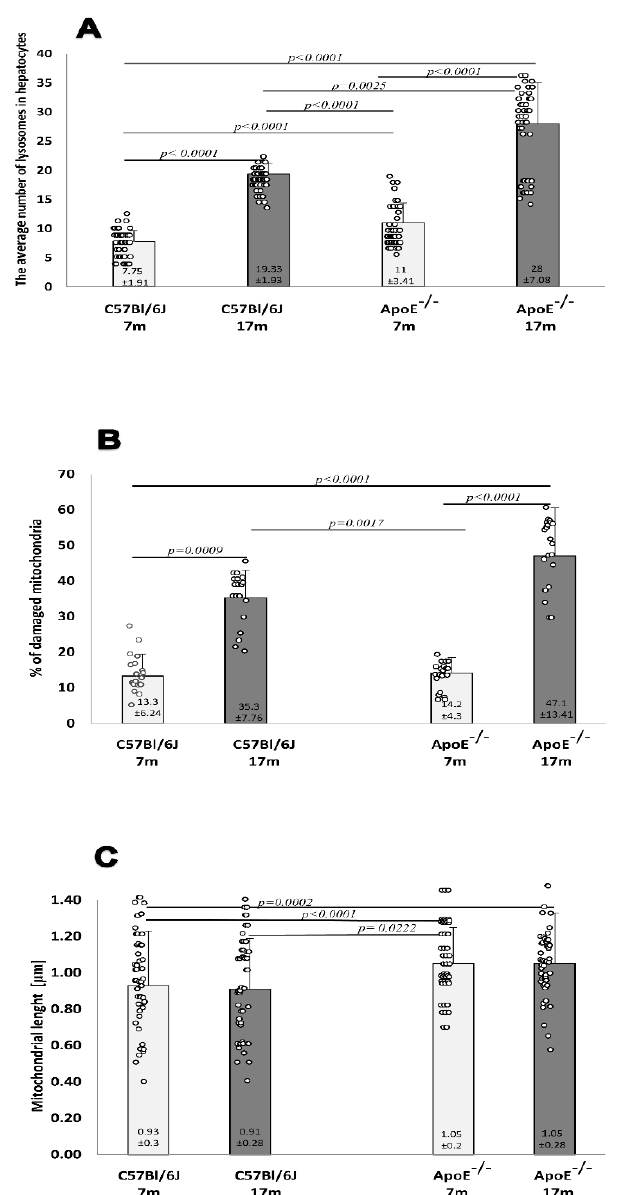
Figure 4. Senescence induces an increase in the number of damaged mitochondria and lysosomes in the mouse liver. Quantitative analysis of lysosomes in hepatocytes ( A ). The relative number of damaged mitochondria (percentage total per 1000 mitochondria counts) ( B ). The average length of mitochondria in hepatocytes ( C ) of C57Bl/6J and ApoE − / − mice both aged 17 months and 7 months. Data were analyzed by a two-way Kruskal–Wallis test (exact F values for genotype and age in panel A are 113.79 and 562.74, in panel B are 5.41 and 101.54, and in panel C are 8.73 and 1.14, respectively) followed by Dunn’s multiple comparison post-hoc test. Shown are the means ± standard deviations. The significance of differences between compared groups are marked with obtained p -values ( p ) for each significant comparison; the different genotype groups were not littermates; row data are depicted by circles; m–months